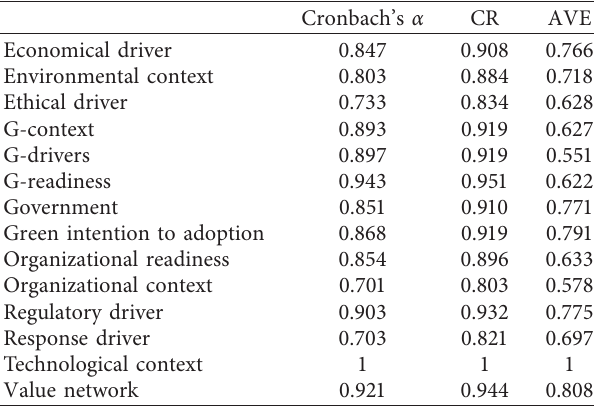
Table 2: CR, Cronbach’s α , and AVE.